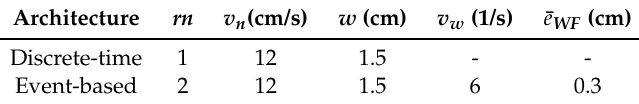
Table 2. Experiment 2: wall following